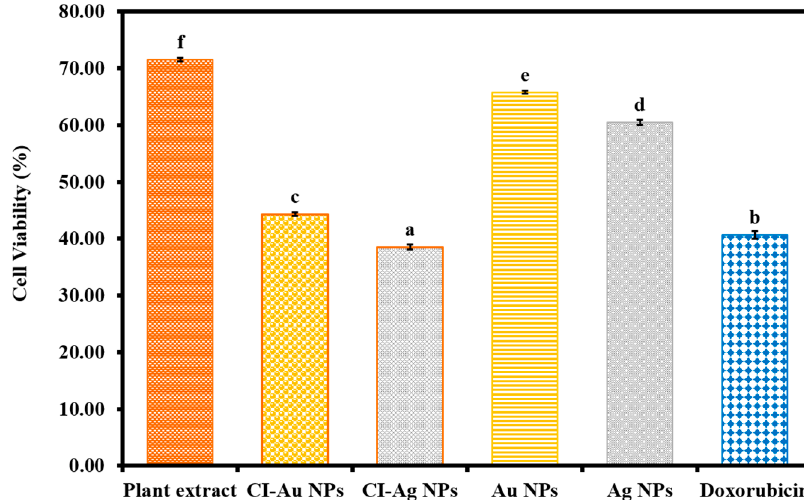
Figure 13. Cytotoxicity activity of green synthesized CI-Au NPs and CI-Ag NPs against the MCF-7 cancerous cells compared to C. inerme leaves extract, Au NPs, Ag NPs, and standard drug. (Note: Tukey based heterogeneous lower-case letters represent significant statistical pairs) .